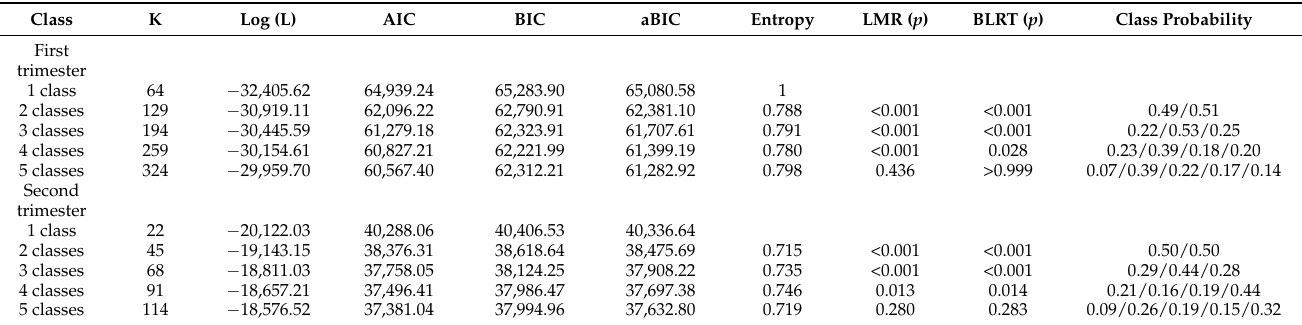
Table 2. Fit statistics for a series of latent class analysis models of prenatal food groups intakes.